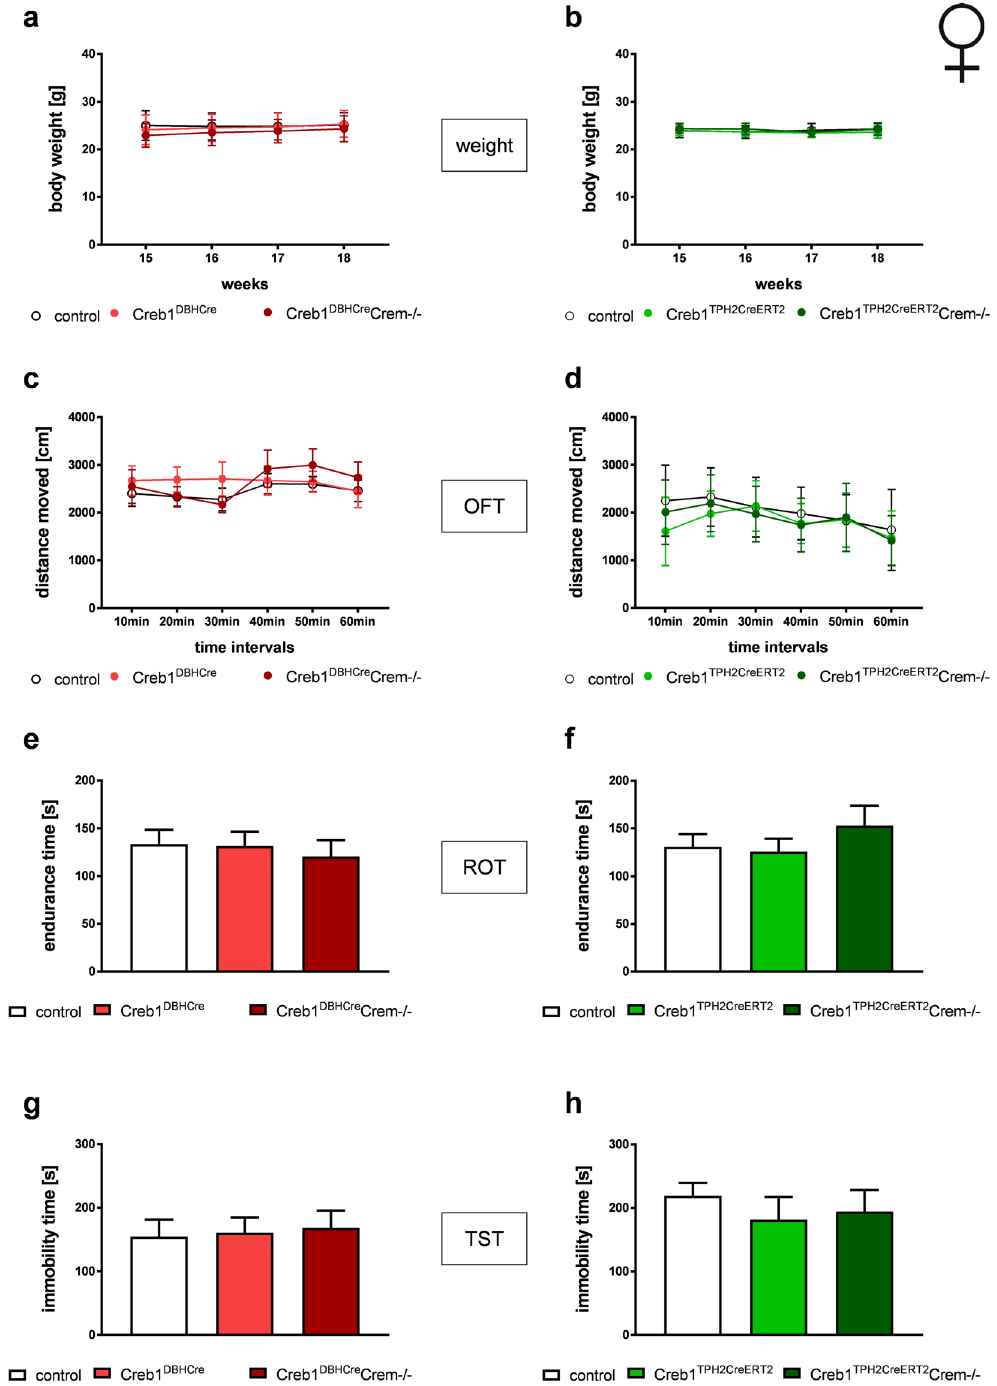
Figure 4. Female Creb1 DBHCre /Crem − / − (left panel) and Creb1 TPH2Cre /Crem − / − (right panel) mice do not show gross abnormalities and altered behavior under basal conditions. ( a , b ) body weight gain, ( c , d ) spontaneous locomotor activity assessed by open field test (OFT), ( e , f ) motor coordination assessed by rotarod test (ROT), ( g , h ) depressive-like behavior assessed by tail suspension test (TST). Data are the mean ± SEM, n =